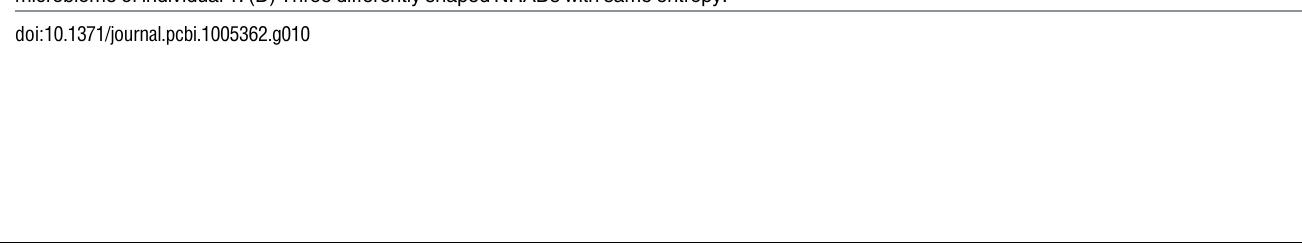
Fig 10. GlobalPatterns dataset. (A) Hierarchical clusteringdendrogram basedon distances betweenNRADs. (B) NRADs of three samples of similar origin that form a cluster. (C) Microbiomeof humanpalm of humanindividual 1 clusters closely with sediments2 and 3, but is more distant to tongue microbiomeof individual1. (D) Three differently shapedNRADs with same